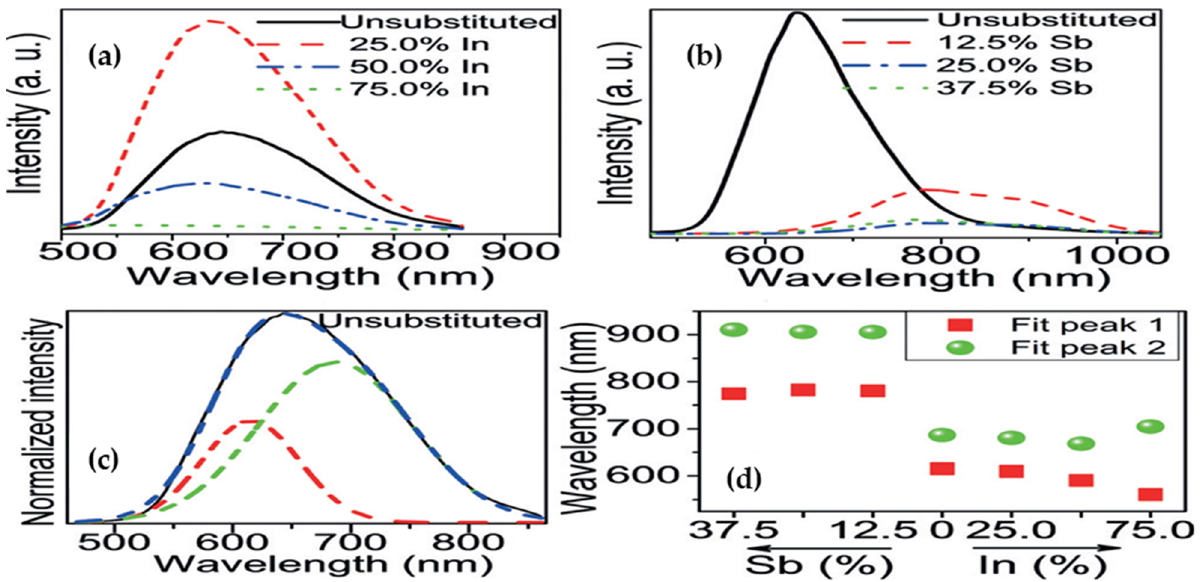
Figure 15. PL spectra for ( a ) In-alloyed; ( b ) Sb-alloyed samples; ( c ) for Cs2AgBiBr6, fitted using a Gaussian function. Red: fit peak 1, green: fit peak 2, blue dashed line: cumulative fit peak. ( d ) Fitted PL peak positions as a function of Sb and In alloying ratio. Reproduced with permission from [92] . Copyright 2017, Wiley-VCH.